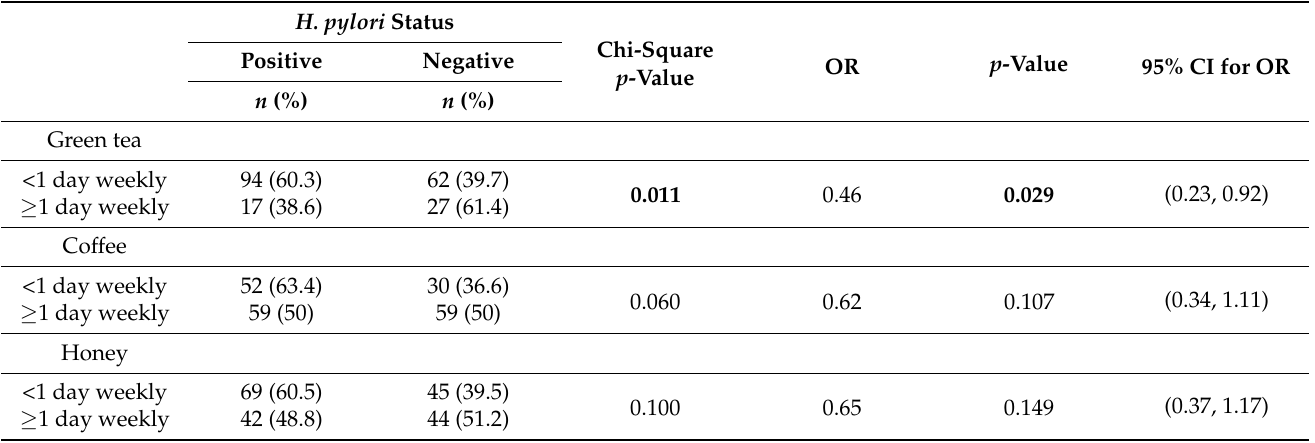
Table 4. Association between H. pylori status with green tea, coffee, and honey